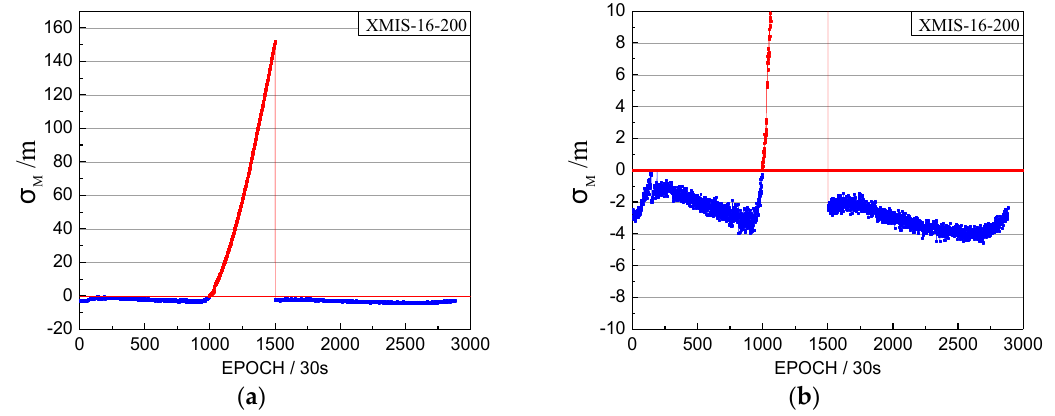
Figure 3. The time factor of the orbital maneuver for XMIS station on 18 July 2016. ( a ): The normal vertical axis scale shows overall information; ( b ): The amplified vertical axis scale shows more detailed information.